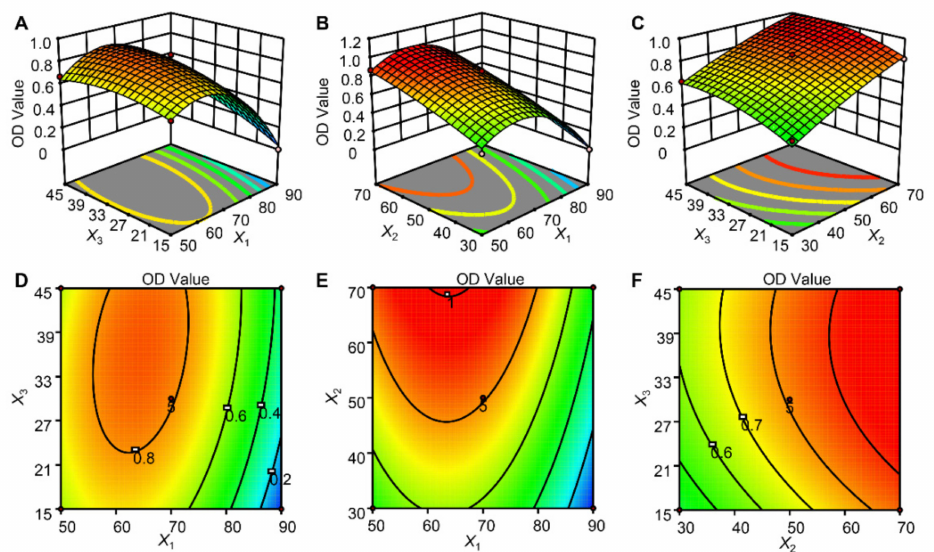
Figure 2. 3D-response surface plots and 2D-contour plots showing the effect of different extraction parameters ( X 1 : proportion of methanol–water , %; X 2 : liquid to solid ratio, v / w ; X 3 : extraction time, min) on the response yield. Keeping X 2 constant at 50 mL/g, X 3 constant at 35 min, and X 1 constant at 70% ( v / v ) for ( A , D ), ( B , E ) and ( C , F ),